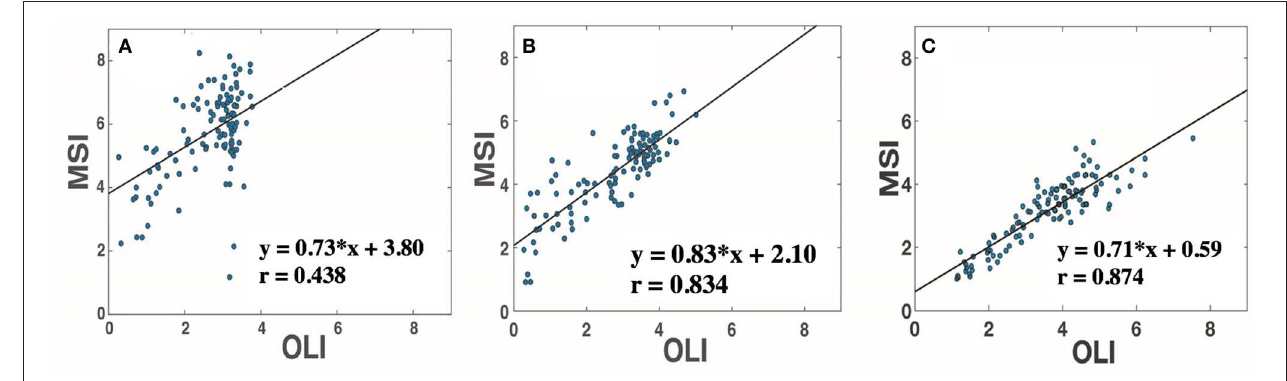
Month OC2-algorithm collocated OLI and MSI observations SD OLI (mg/m 3 )